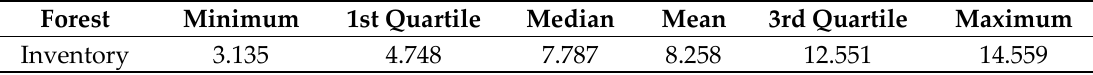
Figure 1. Graphic depicting of databases: ( a ) indicates values of biomass increasement sampled in managed and not managed forests, with some anomalies detected for higher biomass values of not managed forests; ( b ) performs of a joint database obtained after inventories, where a positive skewed distribution can be noticed. Table 2. Statistics of the growth biomass values (Mg ha − 1 ). 2011–2017. A general